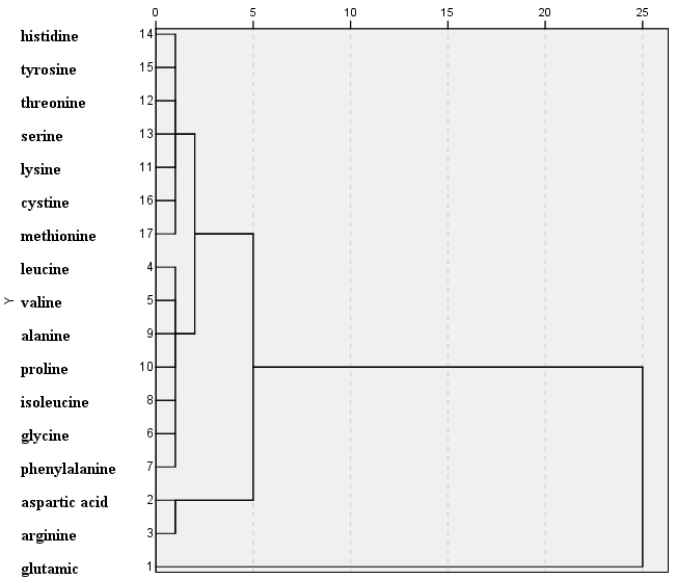
Figure 2. Clustering of amino acids identified in sunflower seed kernels.